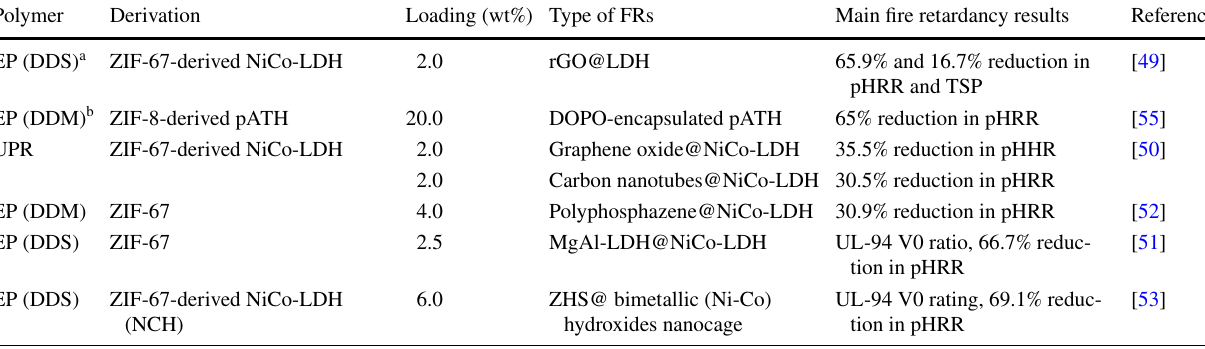
Table 1 Summary of MOF‑derived FRs on flame retardancy of polymer composites